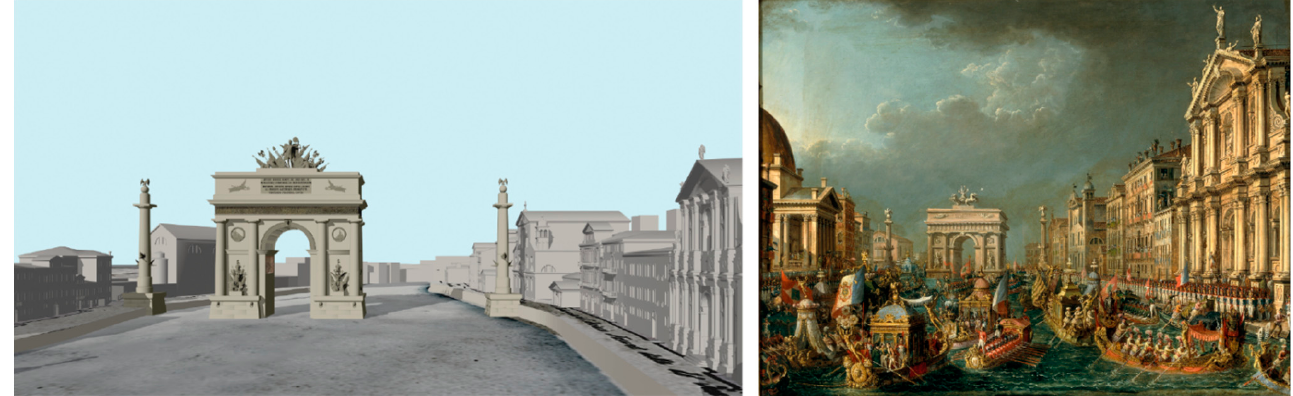
Figure 19. Comparison between Borsato’s painting depicted in 1809 and the view on the model obtained from the grip center calculated by SfM algorithms.